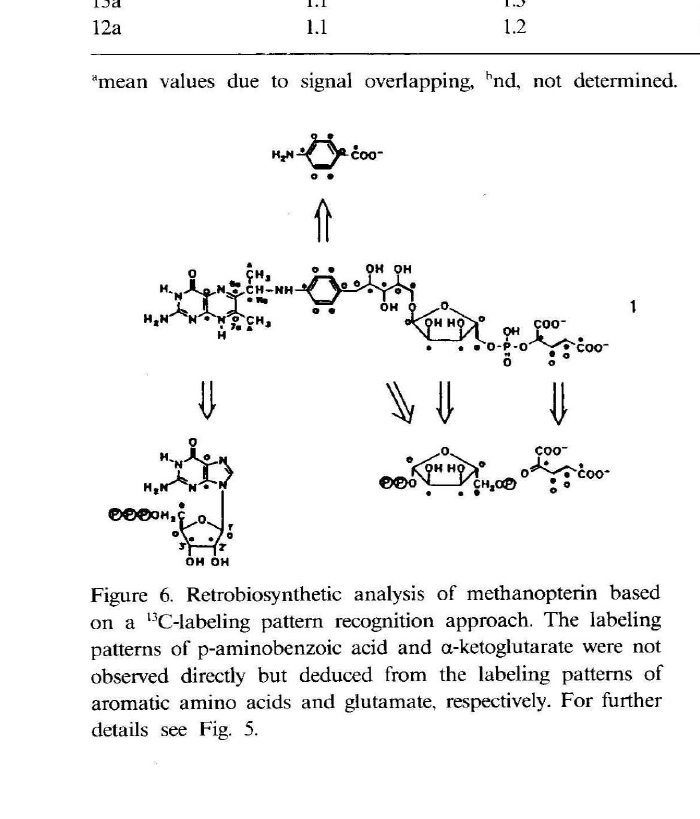
Figure 6. Retrobiosynthetic analysis of methanopterin based on a \3C-labeling pattern recognition approach. The labeling patterns of p-aminobenzoie acid and a-ketoglutarate were not observed directly but deduced from the labeling patterns of aromatic amino acids and glutamate, respectively. For further details see Fig.